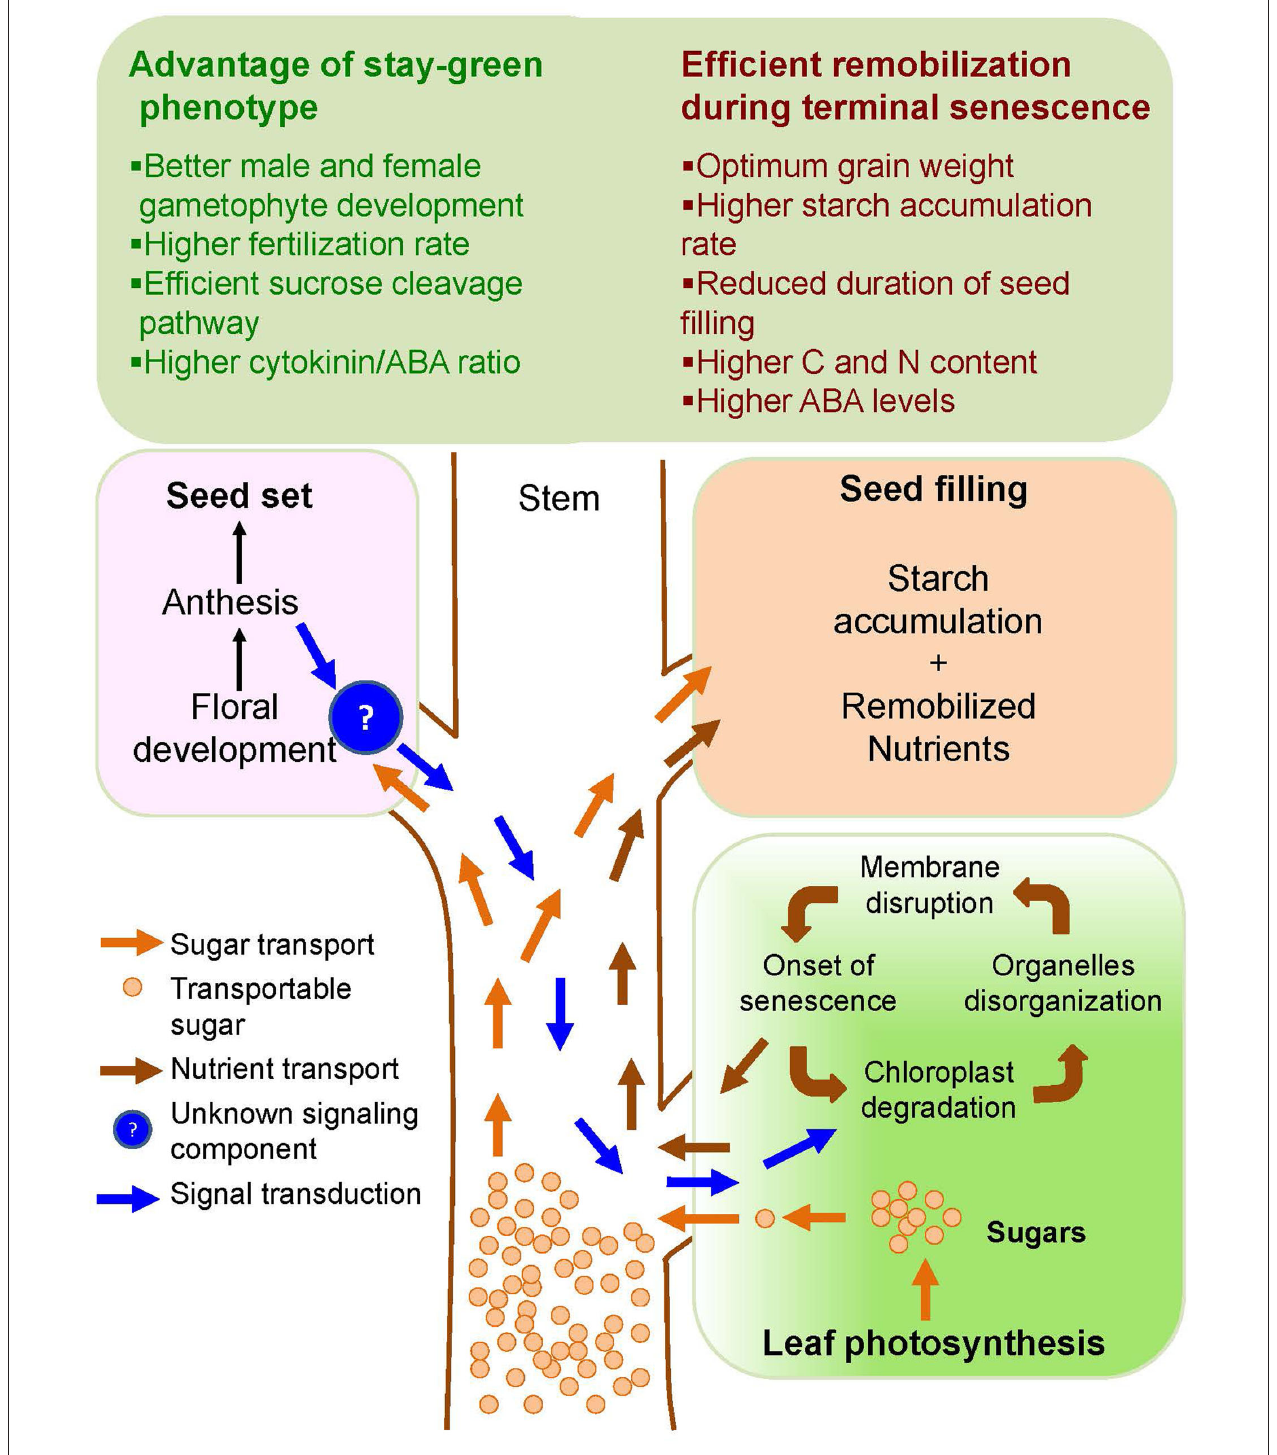
FIGURE 1 | Schematic diagram showing integrative effect of stay-green and terminal senescence traits in plants. Extended stay-green trait provides sufficient photosynthate available as transportable sugar (orange arrows) for floral development and higher starch accumulation during grain filling. Conversely, initiation of terminal senescence after seed set provides additional nutrient supply (brown arrows) to the developing grains to improve optimum grain weight and quality. An unknown signaling component (?) from the floral organ (blue arrows) is thought to initiate the senescence process in leaves.